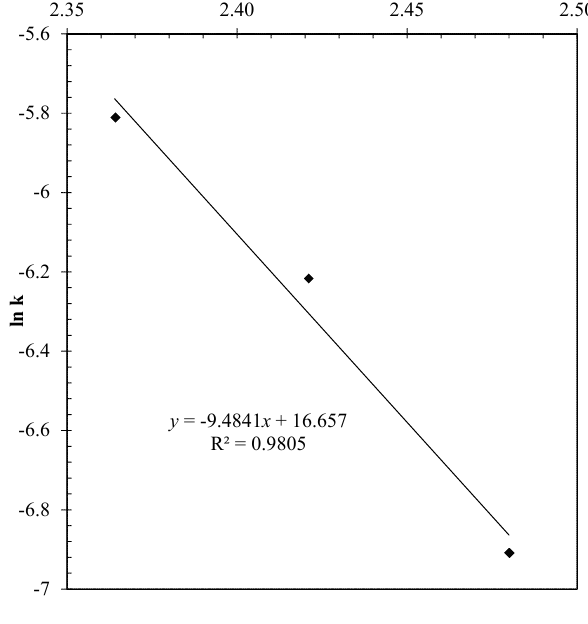
Figure 11. Arrhenius Plot.